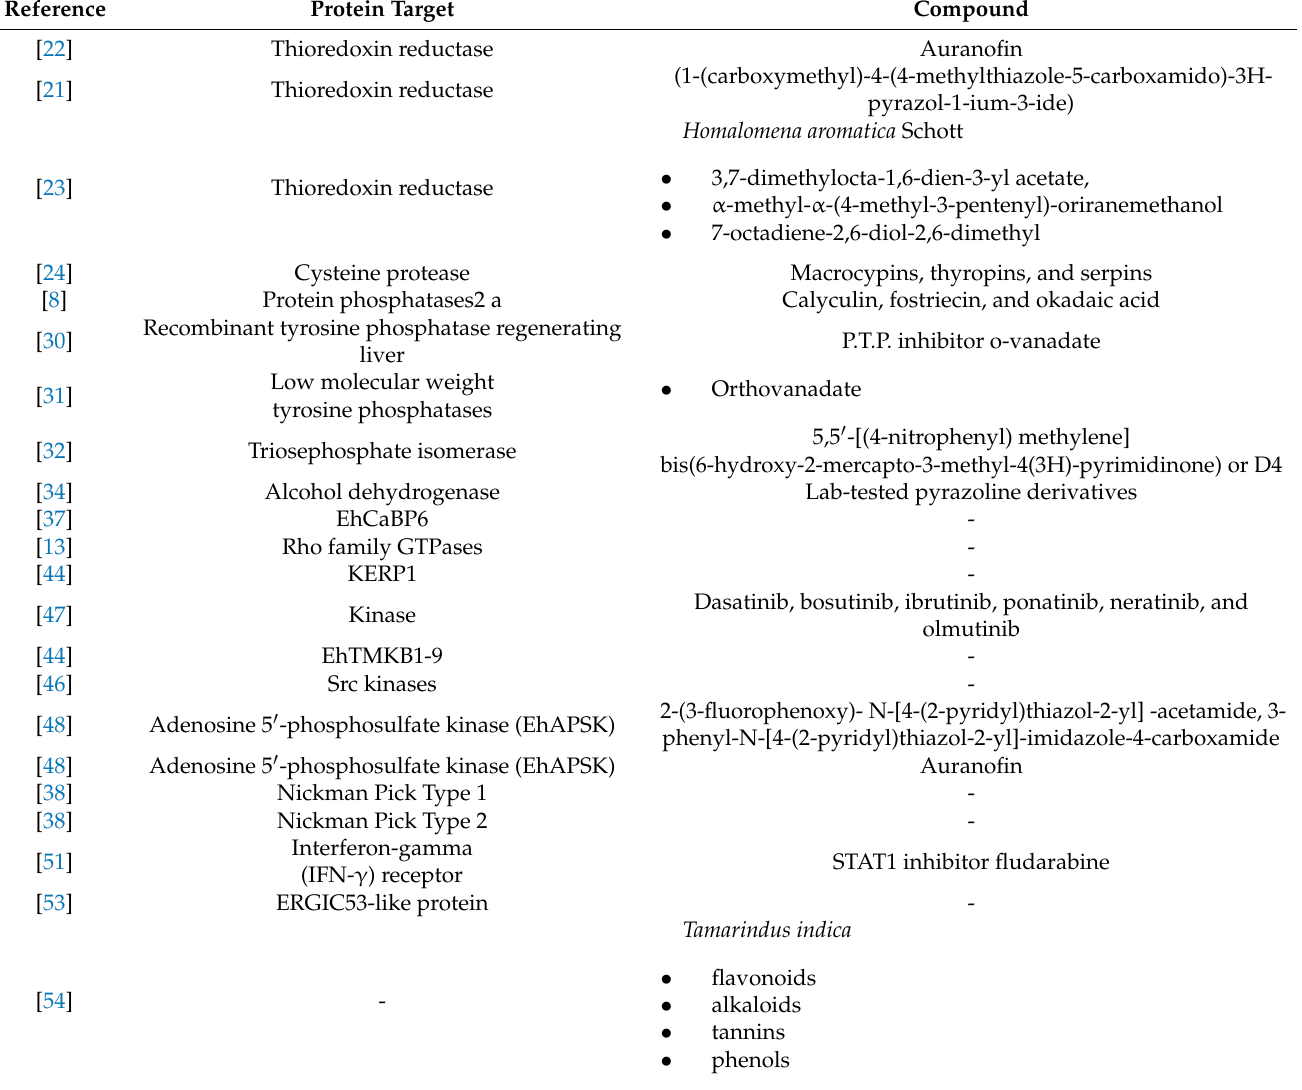
Table 1. The table below summarizes the compilations of the compounds and target